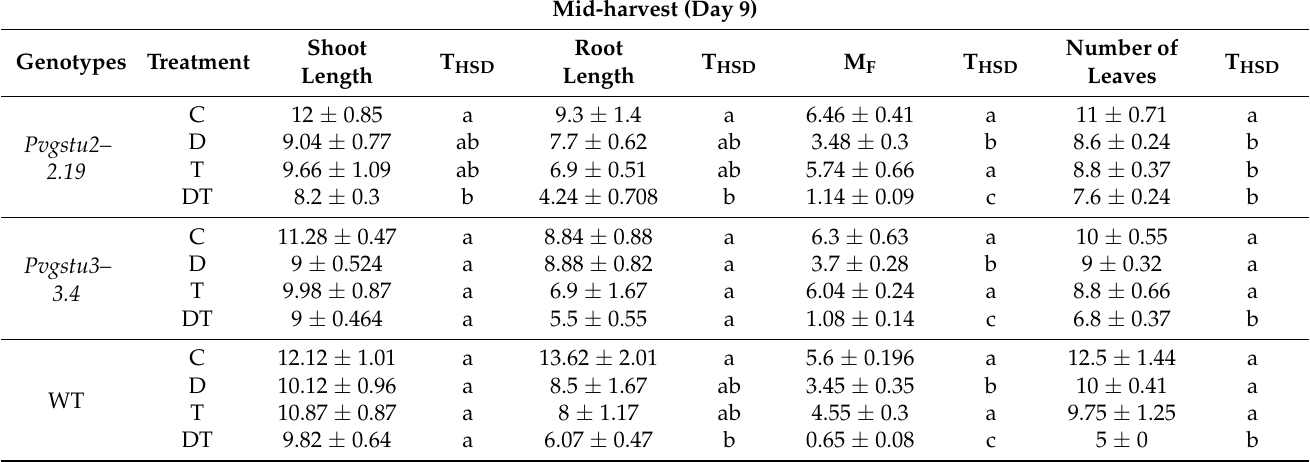
Figure 2. Dry matter (M D ) (g) of the transgenic lines Pvgstu3–3.4 and Pvgstu2–2.19 and WT plants growing under control (C), drought (D), heat (T) and combination of drought and heat stresses (DT) at nine and 16 days. Different letters indicate significant differences among genotypes for each treatment at p < 0.05. Data are means ± SE (WT: n = 4; Pvgstu lines at 9 days: n = 5; at 16 days: n = 7). Table 1. Growth traits of the Pvgstu transgenic lines and WT tobacco plants grown for nine days in drought (D), heat (T) and a combination of drought and heat (DT) stresses. Tukey’s HSD (T HSD ) post hoc test was performed for the treatment effect on shoot and root length, fresh matter (M F ) and the number of leaves for each genotype. Data are means ± SE (WT: n = 4; Pvgstu lines: n = 5). Different letters indicate significant differences between treatments for each genotype at p < 0.05.